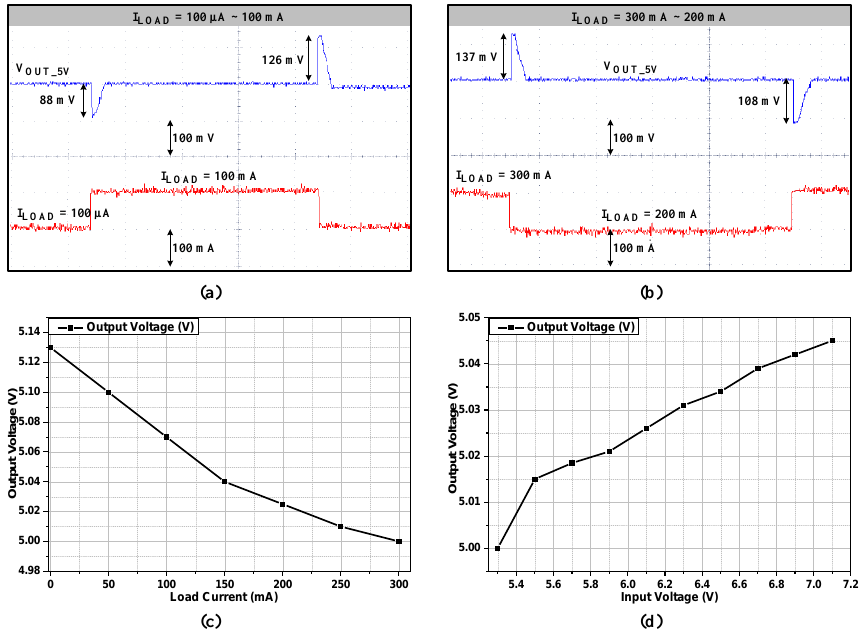
Figure 8. Measured results of LDO_5V. ( a ) Load transient response from 100 µ A to 100 mA. ( b ) Load transient response from 300 mA to 200 mA. ( c ) Load regulation. ( d ) Line regulation. Figure 9 shows measurement results of LDO_3V. Figure 9a depicts a load transient response from 100 µ A to 100 mA with maximum undershoot and overshoot of 72 mV and 96 mV, respectively. Figure 9b displays load regulation for a load current ranging from 10 µ A to 100 mA. The dc variation in the output voltage is around 70 mV, which is 2.34% of the output voltage ( V OUT _3 V = 3V). Figure 9c presents line regulation at 100 mA load current for input range of 5.3 V to 6.5 V. The dc variation in output voltage for this input voltage range is 56